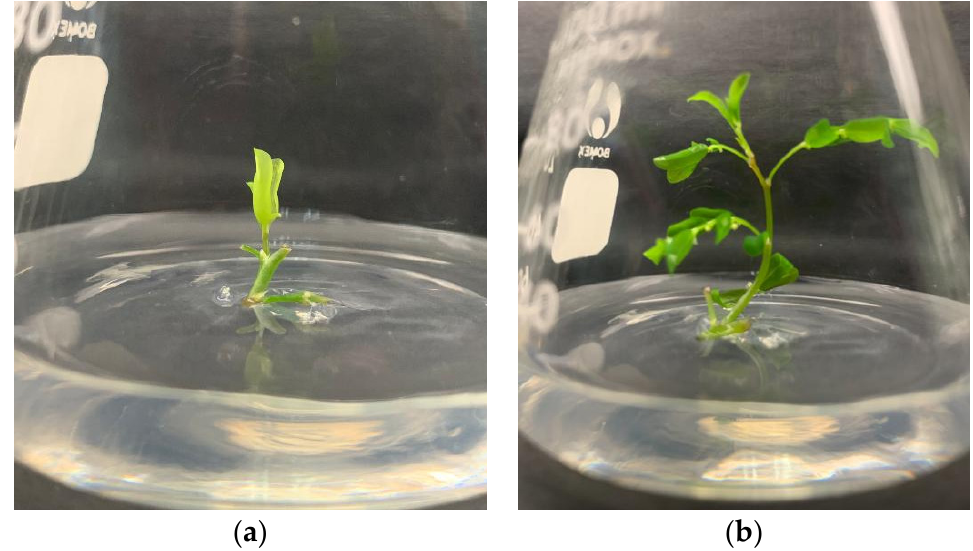
Figure 1. ( a ) Axillary bud proliferation of P. niruri in MS media; ( b ) Elongated shoot of P. niruri in MS media and control treatment after 2 weeks of inoculation.